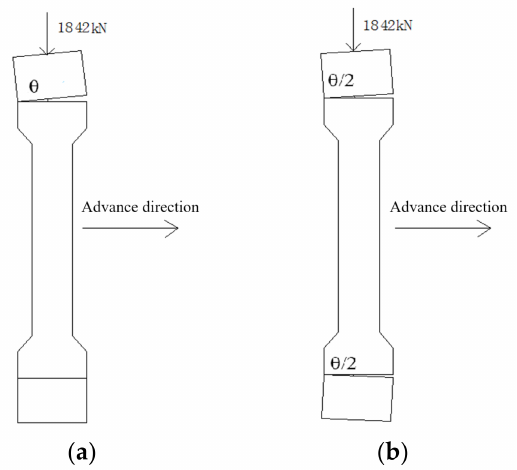
Figure 25. Calculation of the working conditions of the LZ block attitudes. ( a ) Condition 1; ( b ) Condition